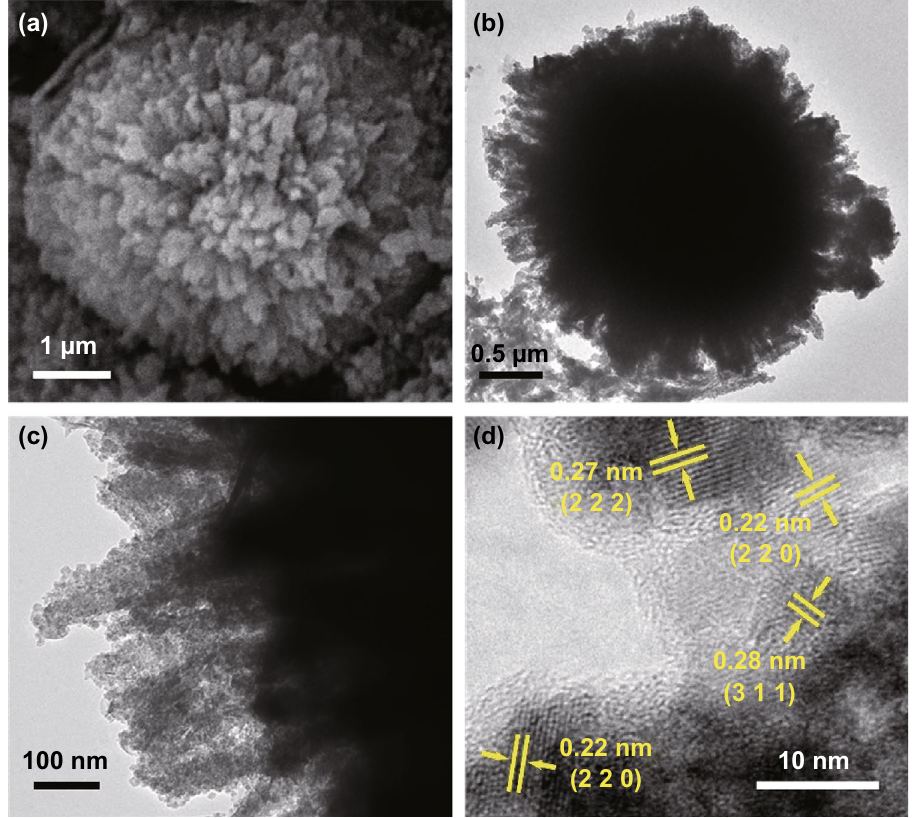
Fig. 7 a SEM, b , c TEM, and d HRTEM images of NCS@MCMB after